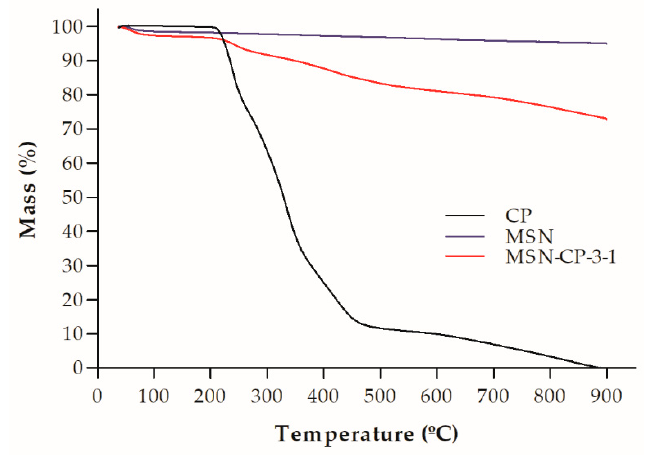
Figure 1. Thermogravimetric analysis of crystalline CP, bare MSN (MCM − 41) and MSN-CP − 3 − 1.